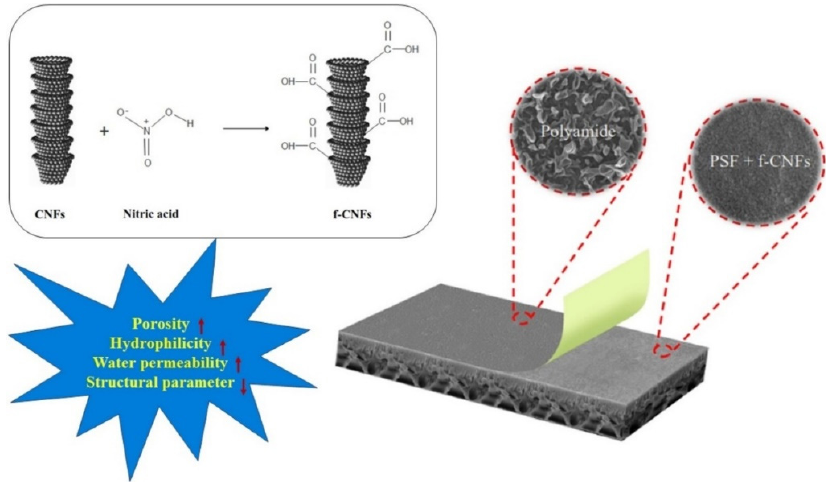
Figure 4. Thin film composite membrane for forward osmosis made of polysulfone matrix/functionalized CNFs with the polyamide rejection layer. Diagram taken from [62].